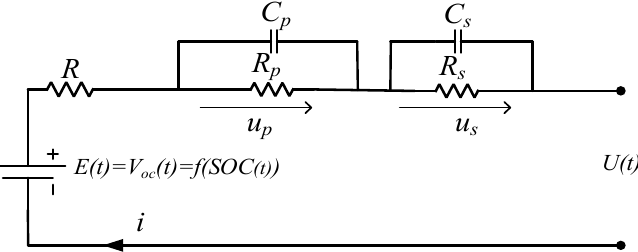
Figure 1. The second ‐ order RC equivalent circuit.